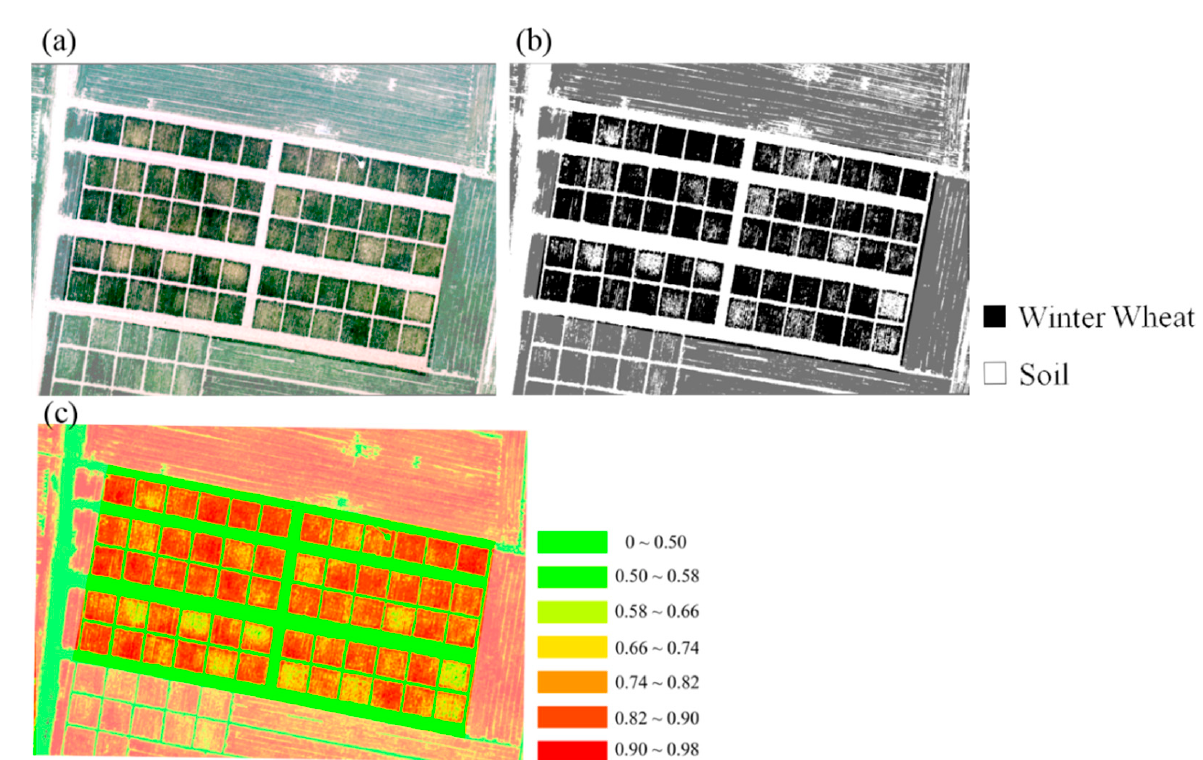
Figure 4. UAV-based images of winter wheat under different basal fertilizer levels. ( a ) RGB. ( b ) NDVI. ( c ) Coverage.